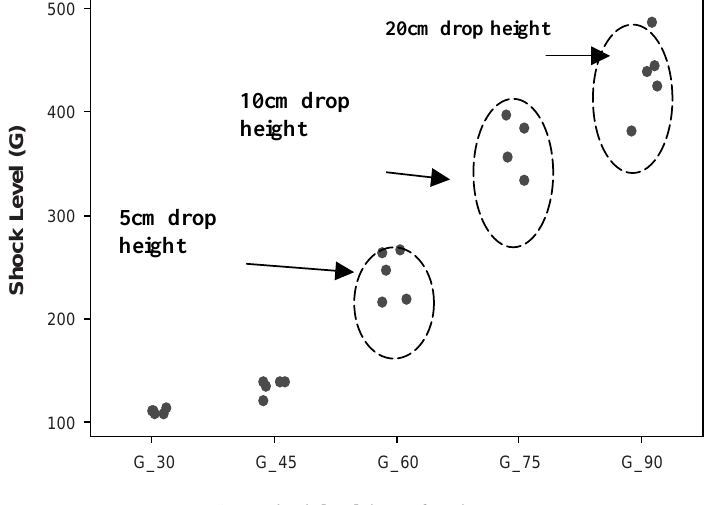
Fig. 7. Shock level due to free drop.